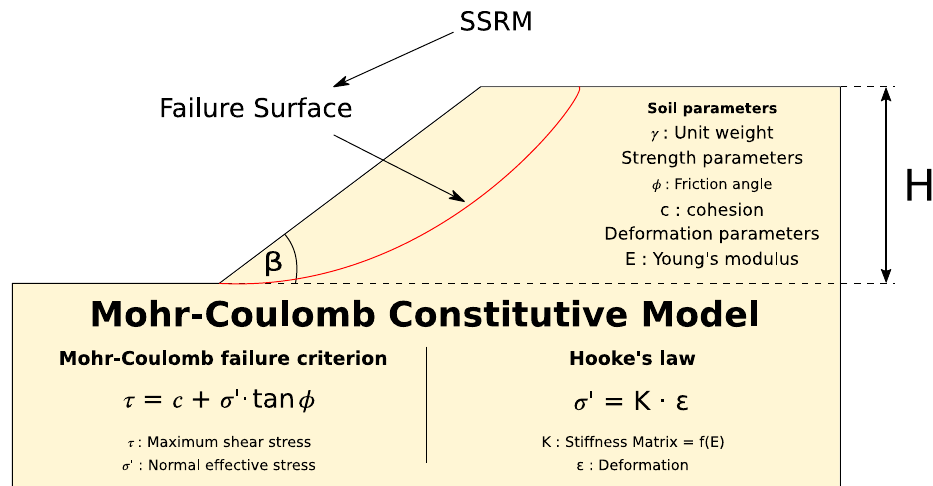
Figure 2. Conceptual diagram of the geotechnical model of a slope.